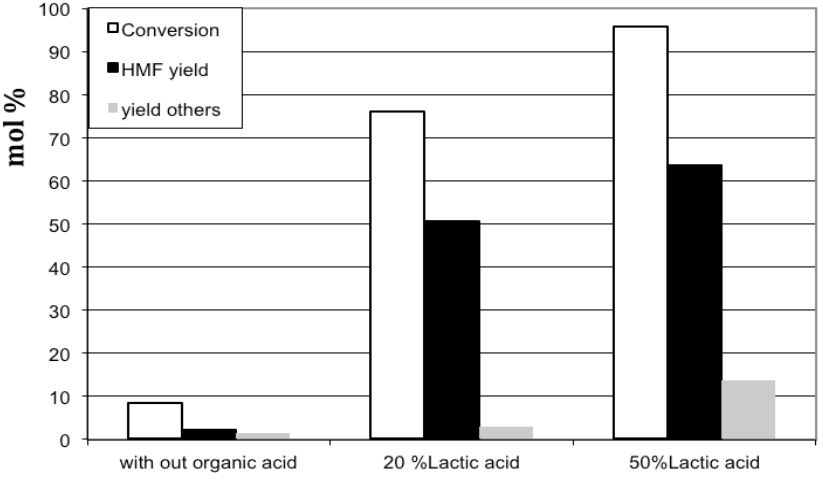
Figure 15. Fructose dehydration in 5-HMF obtained in lactic acid aqueous solutions of 1 various compositions in the absence of added solid catalyst.